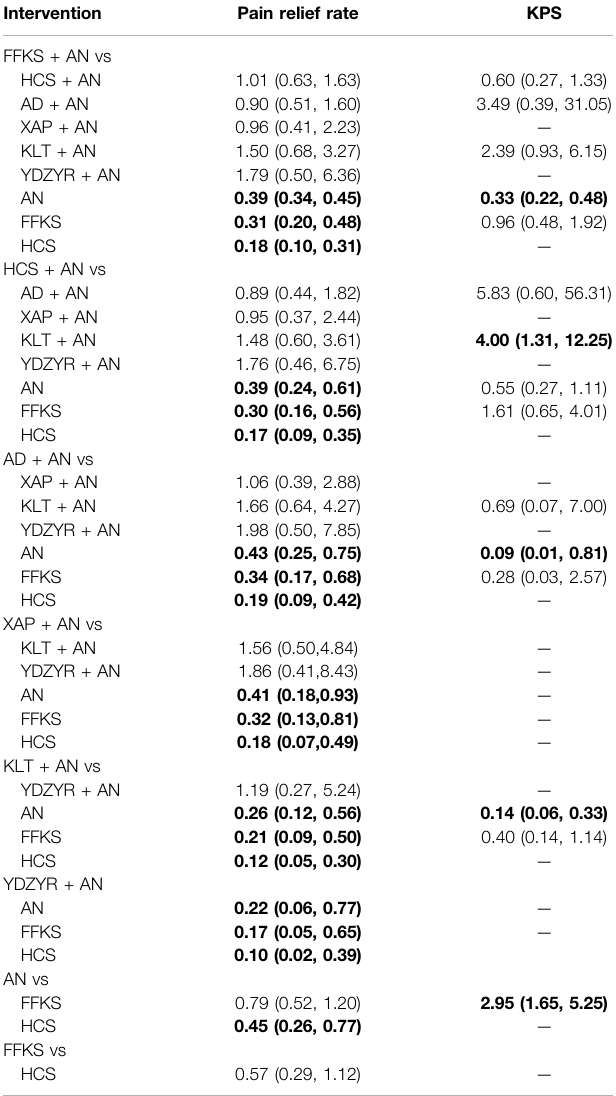
Note: Bold results indicate statistically signi fi cant differences between groups. FFKS + AN, Fufangkushen injection + analgesic; HCS + AN, Huachansu injection + analgesic;AD+AN,Aidiinjection+analgesic;XAP+AN,Xiaoaipinginjection+analgesic; KLT + AN, Kanglaite injection + analgesic; YDZYR + AN, Yadanziyouru injection + analgesic; AN, analgesic; FFKS, fufangkushen injection; HCS, huachansu